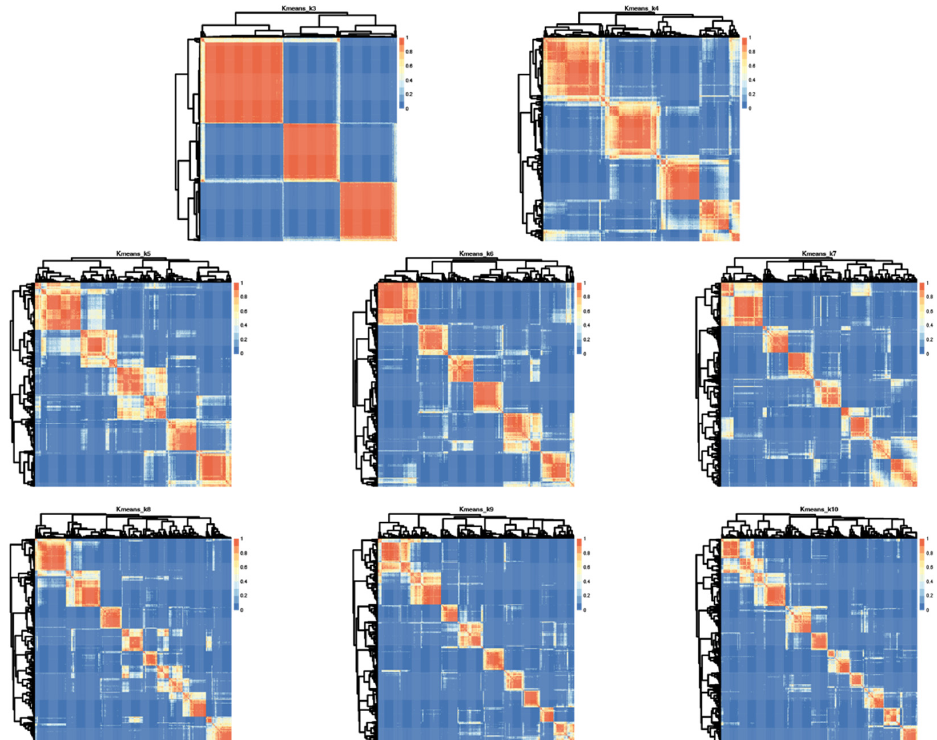
Figure 3. Iterative cluster analysis reveals optimal repeat clustering when using K means = 6 . Heatmaps showing overlap for consensus clusters generated using K = 3–10 based on input from all 38 questions in the SSP. Red indicates 100% consensus and blue indicates no consensus. Lighter shading indicates variation across iterations and thus less consensus.